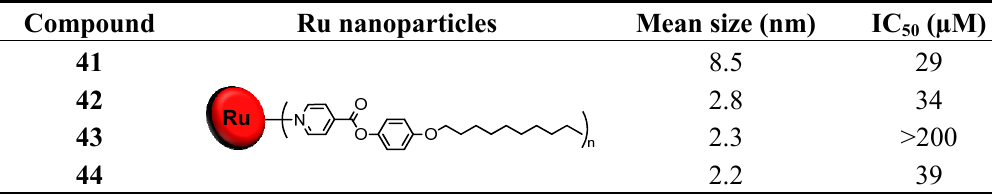
Table 4. IC of the ruthenium (0) nanoparticles, 41 – 44 , on A2780 human ovarian cancer 50 cells after 72 h of